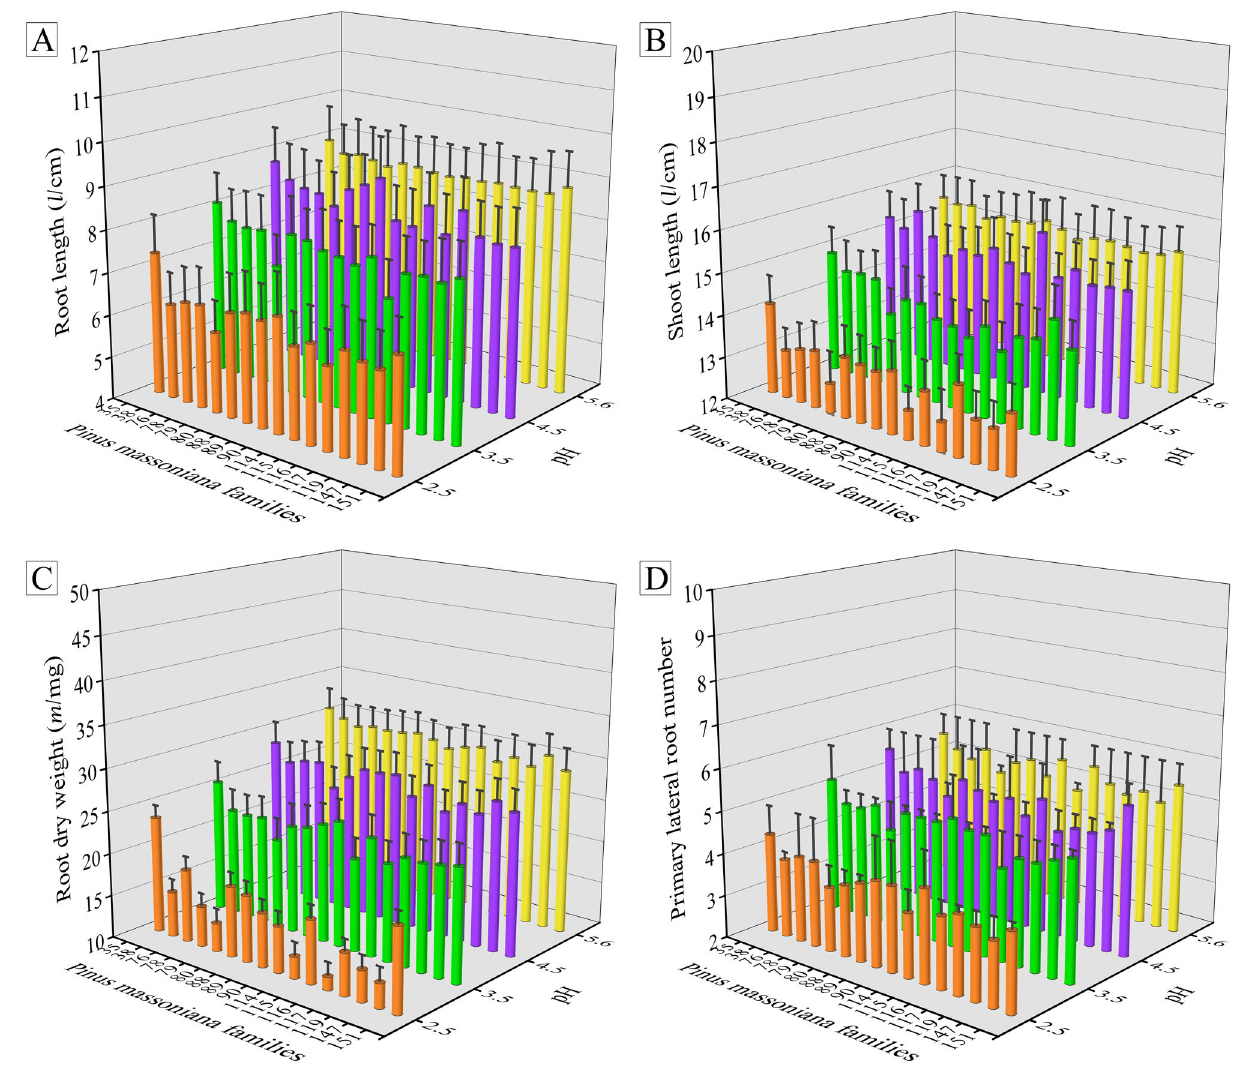
Figure 1. The morphology indexes, ( A ) root length ( l /cm), ( B ) shoot length ( l /cm), ( C ) root dry weight ( m / mg), and ( D ) primary lateral root number of Masson pine families exposed to the SAR at pH of 2.5, 3.5, 4.5 and 5.6. Results are expressed as mean ± standard error (n =